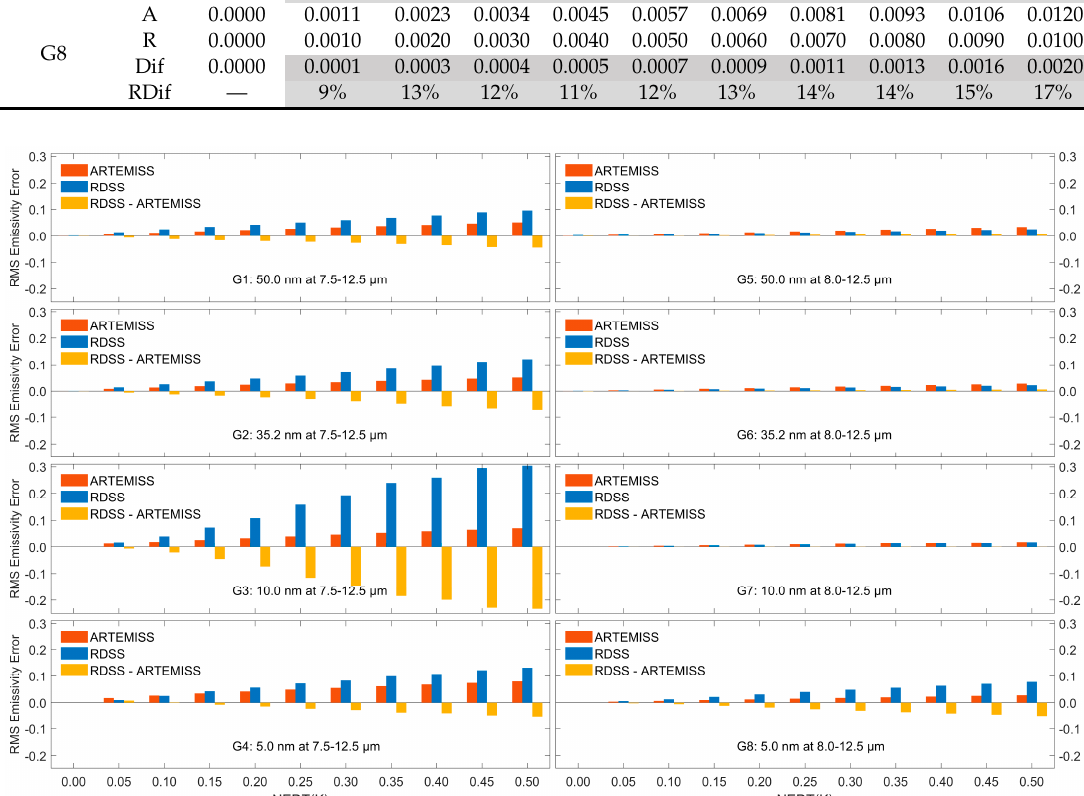
Figure 8 . The comparison of the retrieved LSE RMSEs of RDSS and ARTEMISS. Figure 8. The comparison of the retrieved LSE RMSEs of RDSS and Table 4 . The retrieved LSE RMSE for RDSS and ARTEMISS and their differences. Groups\